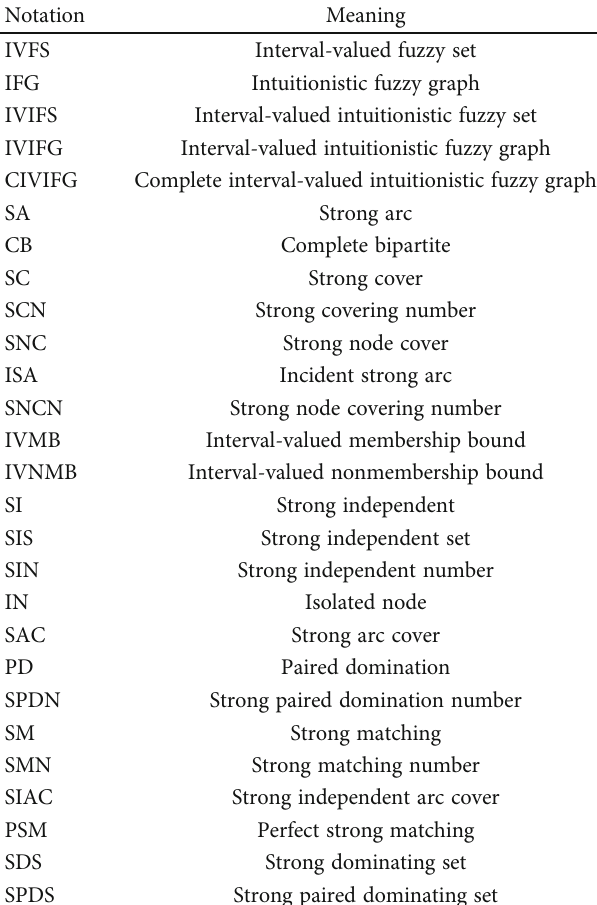
Table 1: Some basic